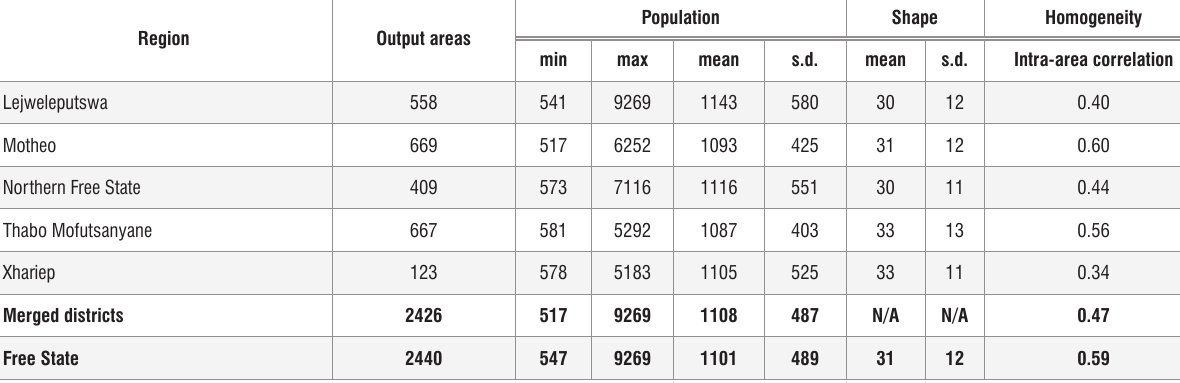
Statistical outputs of merged districts against Free State Province (single run)